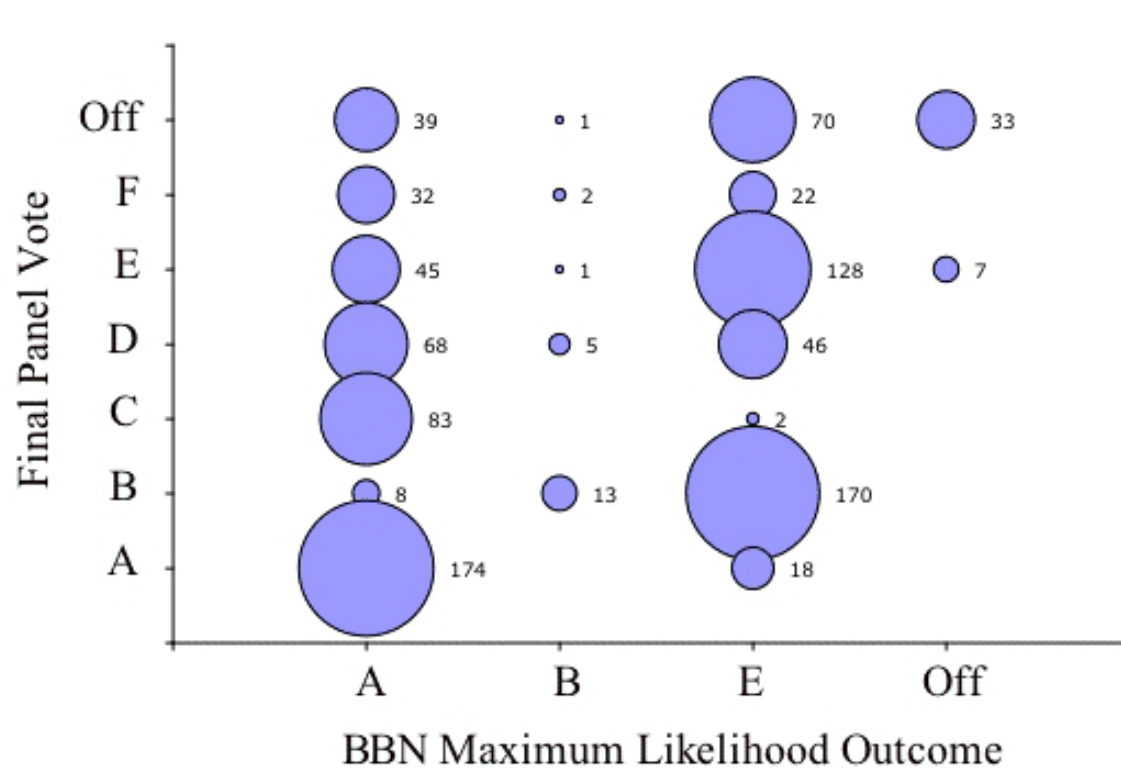
Fig. 10. Distribution of the final votes across all species from the 2002 and 2003 evaluation panels of the Annual Species Reviews under the Northwest Forest Plan, by species conservation management category (A-F and Off the list; see Table 1 for category descriptions), for each maximum likelihood outcome of the overall Bayesian belief network (BBN) model (Fig. 1). The area of each bubble corresponds to the number of votes, also shown next to each bubble. The BBN decision model did not result in species conservation management categories C, D, or F being the most likely outcome for any species, although they were sometimes shown as being less likely